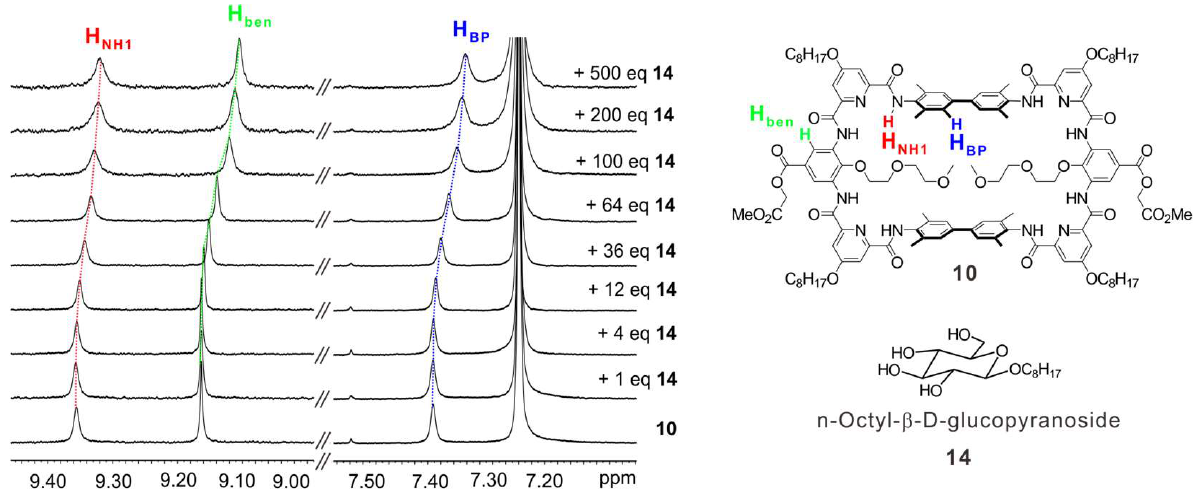
Figure 5. 1 H NMR titration study. From bottom to top, 10 in CDCl 3 (1 mM) titrated with n-octyl- β -D-glucopyranoside ( 14 ) from 0 to 500 equivalents. The dotted lines indicate the chemical shifts of H NH1 (red), H ben (green) and H BP (blue) protons of 10 .